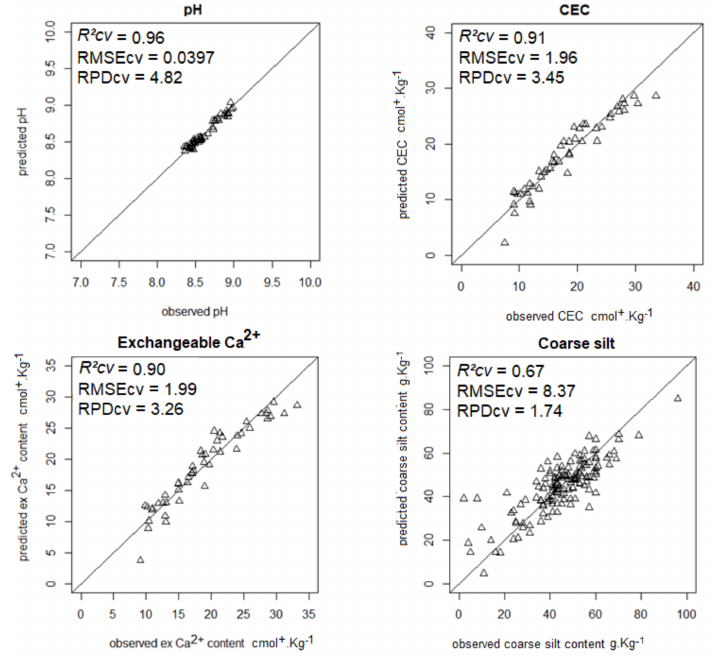
Figure 3. Scatterplots of predicted vs. observed pH, CEC, exchangeable Ca 2+ , and coarse silt contents from model